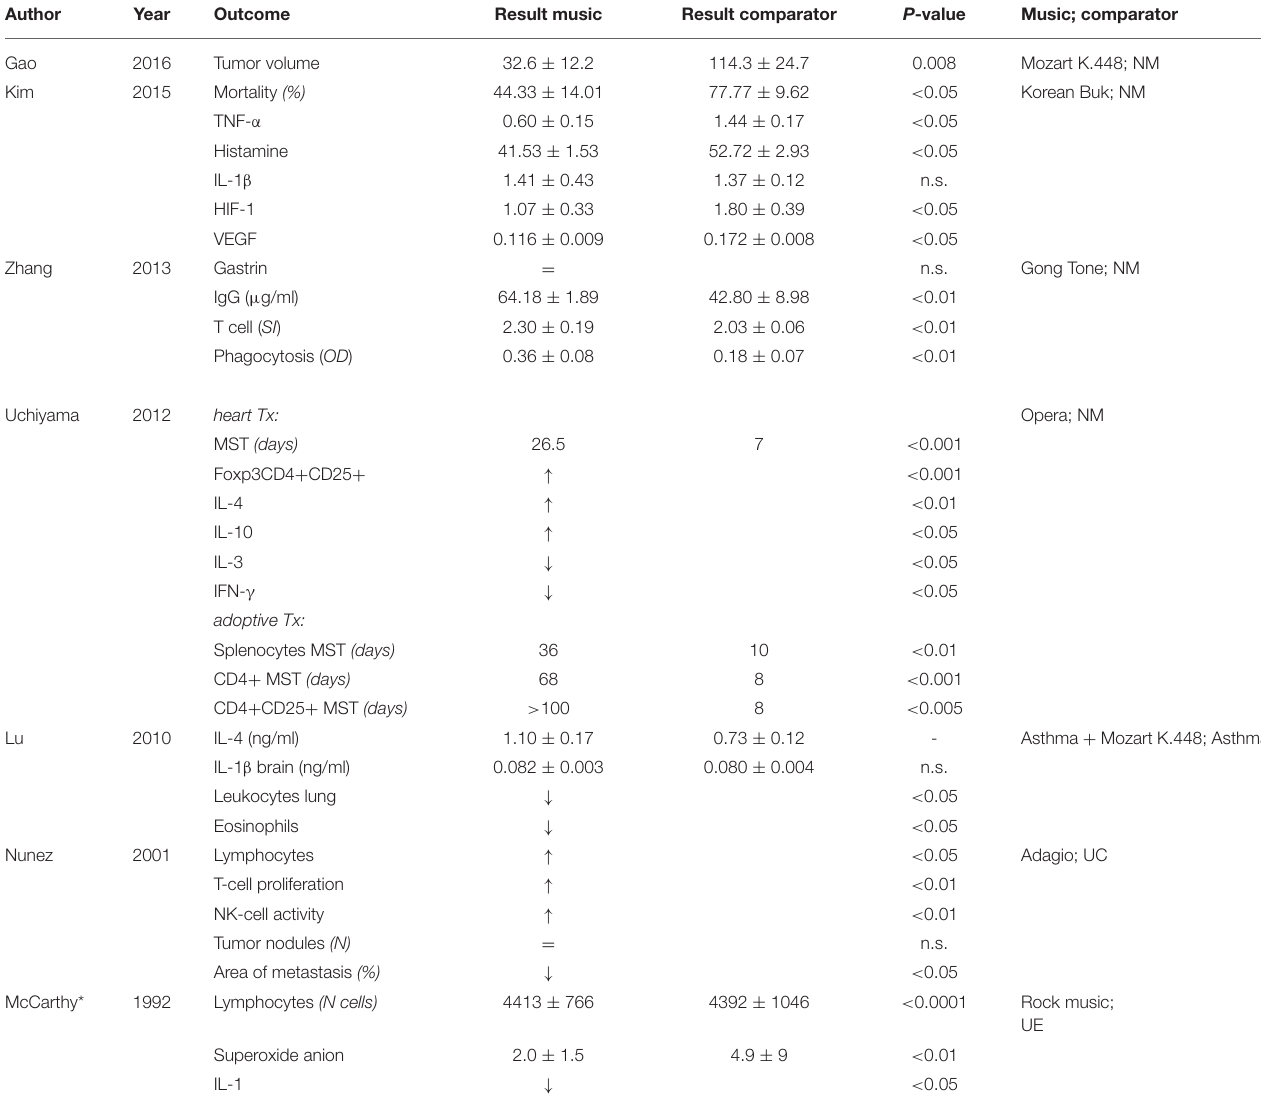
TABLE 4 | Immunologic